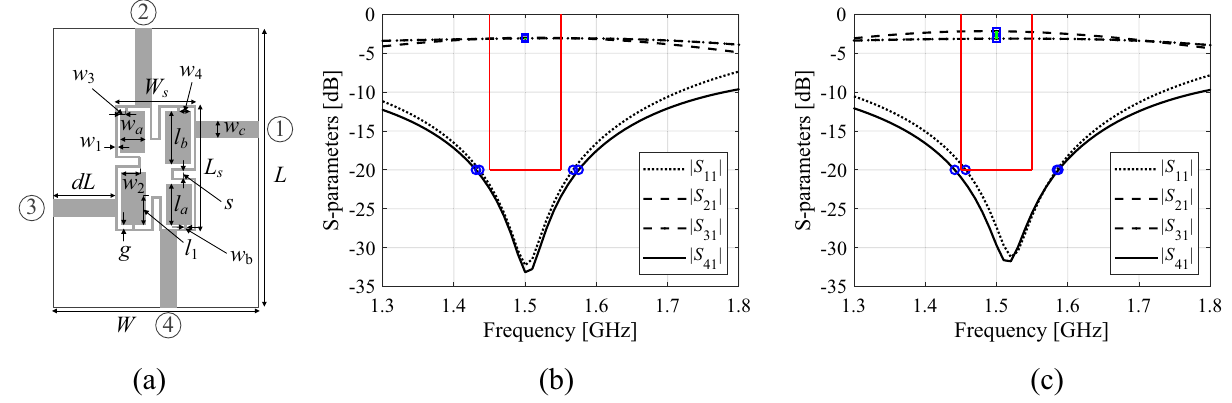
Figure 1. Conceptual illustration of response features for a microwave coupler: S -parameters and feature points representing − 20 dB level of | S 11 | (matching) and | S 41 | (isolation) responses (o), along with | S 21 | and | S 31 | (transmission) at the intended operating frequency f 0 = 1.5 GHz (verbal description: square). The characteristic point coordinates permit assessment of performance requirements satisfaction (100 MHz matching/isolation bandwidth centered around f 0 ), and maximal power split deviation of 0.5 dB at f 0 ): ( a ) coupler geometry, ( b ) design fulfilling specs, ( c ) design infringing power split and bandwidth